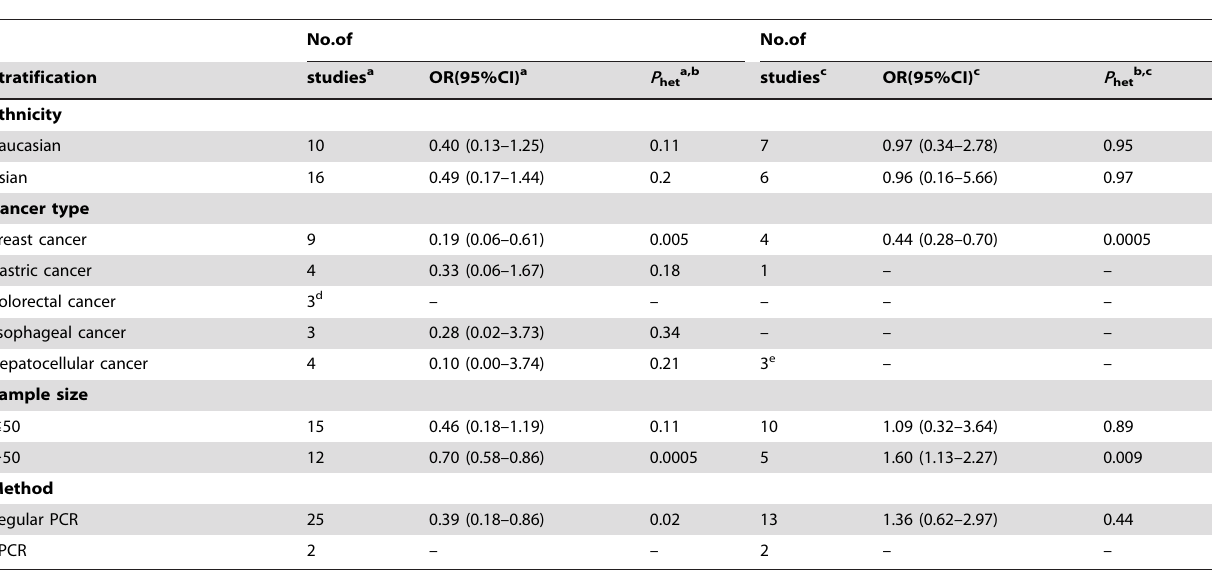
Table 2. The mtDNA 4977 bp deletion status in stratification analysis by selected factors.